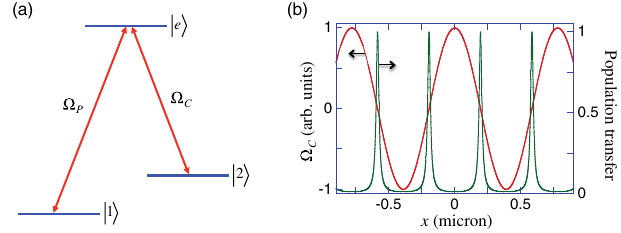
FIG. 1. (a) Three-level (cid:1) scheme for driving the atoms to a dark state and observing EIT. With atoms starting in the ground state j 1 i , the dark state can be prepared using a counterintuitive pulse sequence; i.e., (cid:2) C should be turned on before (cid:2) P . (b) Spatial localization of excitation using the dark state. Because of the sinusoidal intensity profile of the coupling laser (standing wave), the population transfer to state j 2 i is localized to regions near the intensity nodes. The width of the localized regions is controlled by the ratio of the intensities of the probe and coupling laser